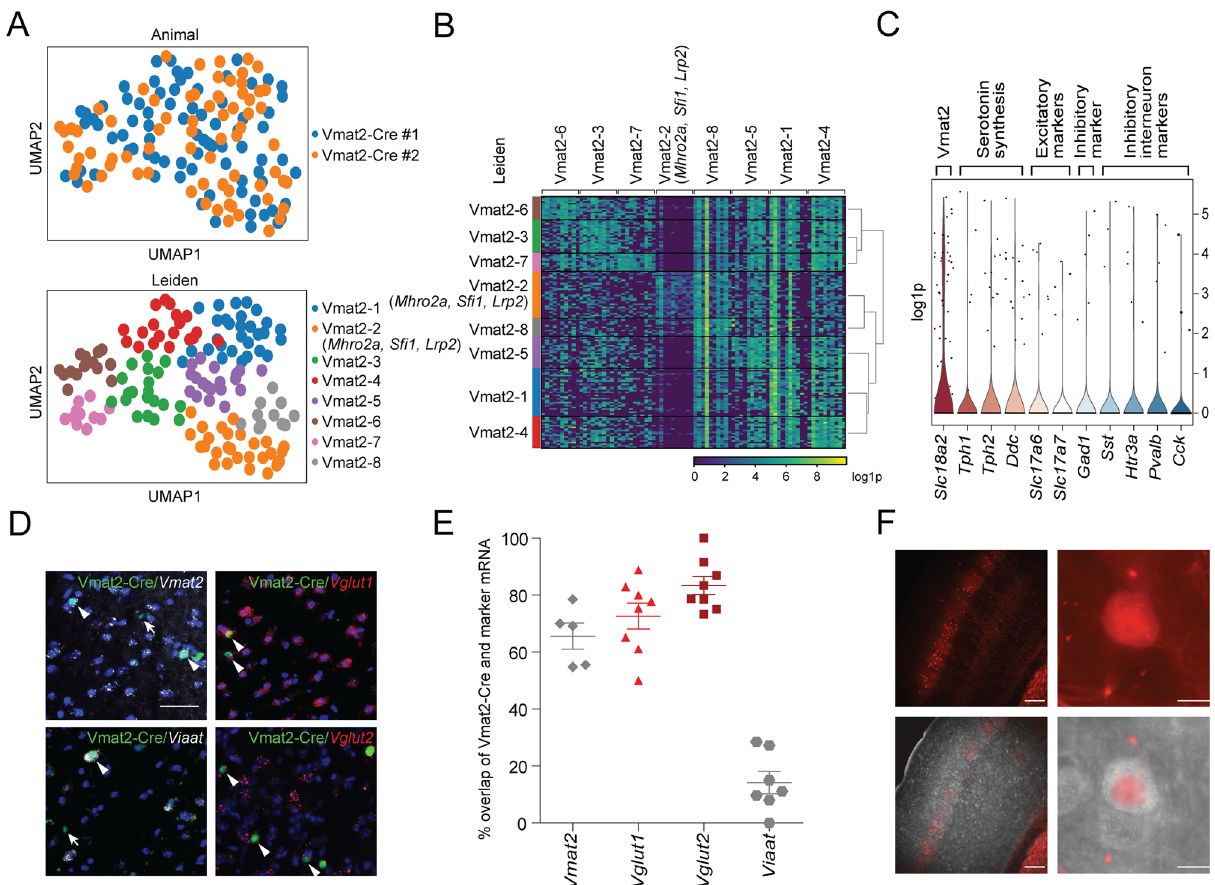
Figure 3. Single-cell mRNA sequencing reveals homogeneity of the Vmat2-Cre; tdTomato population. ( A ) Somatosensory cortical Vmat2-Cre; tdTomato cells from two animals were single-cell mRNA sequenced using Smart-Seq2. Leiden clustering shows that there are 8 clusters of Vmat2-Cre cells, but only one of these clusters (Vmat2-2) shows a significant expression for top differential expressed (DE) marker genes (FDR < 0.05). ( B ) Heatmap of expression of DE genes for individual Vmat2-Cre cells according to assigned Leiden cluster. ( C ) Violin plot of the expression of target neurotransmitter marker genes per cell in the Vmat2-Cre: tdTomato population (gene considered expressed if log1p ≥ 0.25). Images ( A–C ) were generated using SCANPY, https ://scanp y.readt hedoc s.io/en/stabl e/. ( D ) RNAscope detection of neurotransmitter markers Vmat2 (grey, top left), Vglut1 (red, top right), Viaat (grey, bottom left) and Vglut2 (red, bottom right) in SB1F Vmat2-Cre.HTB neurons (green) (scale bar 100 µm). Arrowhead indicates Vmat2-Cre.HTB neuron expressing targeted gene and arrow indicates Vmat2-Cre.HTB neuron not expressing the targeted gene. The images were generated using Fiji (ImageJ 1.52f.), https ://image j.net/Welco me. ( E ) Scatter plot showing the percentage of adult Vmat2-Cre.HTB neurons that express the targeted gene ± SEM. The image was generated using GraphPad Prism version 5.0.1 for Windows, GraphPad Software, San Diego, California USA, www.graph pad.com. ( F ) Immunostaining was performed to detect GABAergic Vmat2-cre ;tdTomato cells in the barrel field cortex (left). Scale bar 200 µm. A Vmat2-cre ;tdTomato cell expressing GABA (right). Scale bar 10 µm. The images were generated Image J (Image J 1.53e), https ://image population ( Slc17a6 : 4.6%, Slc17a7 : 3.3%) whereas the inhibitory markers Slc32a1 (Viaat) was not detected in the dataset and Gad1 was only detected in 3.3% (Fig. 3C). Moreover, low-to-zero expression and prevalence for inhibitory interneuron markers, such as Sst (somatostatin), Htr3a (5-hydroxytryptamine receptor 3a), Pvalb (parvalbumin), Calb2 (calretinin), Npy (neuropeptide Y), Vip (vasoactive intestinal polypeptide), and Cck (cholecystokinin) 21–24 were found (Fig. 3C, Sst : 2%, Htr3a: 3.3%, Pvalb : 3.3%, Calb2 : 0%, Npy : 0%, Vip : 0%, Cck : 2% (genes with 0 expression are not displayed in the figure)) (for a receptor expression analysis, please see Figure S5). The single cell sequencing analysis thus revealed that the Vmat2-Cre; tdTomato cells, in gen- eral, displayed a low prevalence of investigated neurotransmitter marker mRNA (except Vmat2 ) and to further investigate the neurotransmitter phenotype of Vmat2-Cre cells, and in particular Vmat2-Cre cells with active Cre expression in adults, the expression of several neurotransmitter markers were analyzed using RNAscope. Vmat2-Cre expression in cortex layer IV was visualized through a Cre-dependent viral-based technique where AAVDJ.EF1a-DIO-HTB was injected in adult mice (n = 2). The analysis revealed that 65.6 ± 4.1% (69/108 cells) of the Vmat2-Cre.HTB neurons expressed Vmat2 , 72.6 ± 4.3% (178/237 cells) Vglut1 , 83.5 ± 2.2% (123/149 cells) Vglut2 and 14.2 ± 3.6% (18/125 cells) Viaat (Fig. 3D,E), indicating that the adult Vmat2-Cre population is mainly